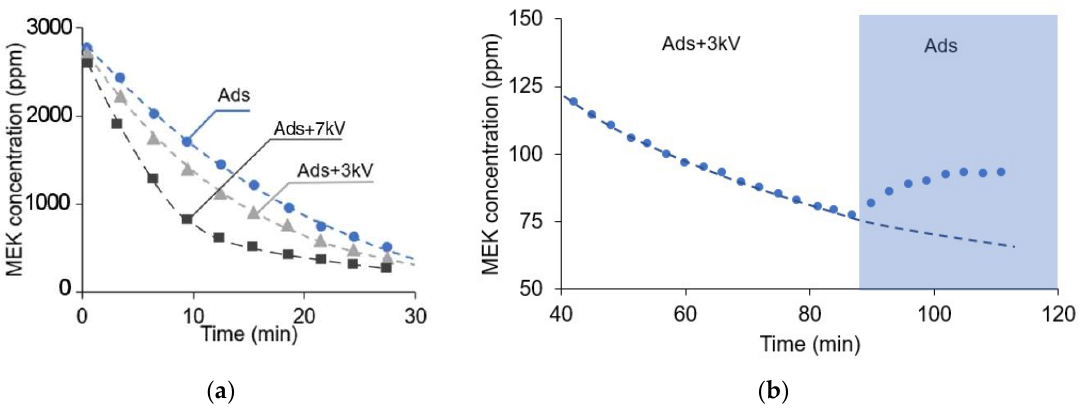
Figure 6. ( a ) Methyl Ethyl Ketone concentration in the absence and presence of the electric field. ( b ) MEK concentration in the test where the electric field was first switched on and then off. Fitted values of the Error! Reference source not found. , relatively to the batch adsorption tests, are reported in Table 5. Table 5. Results of the experimental batch adsorption kinetic data